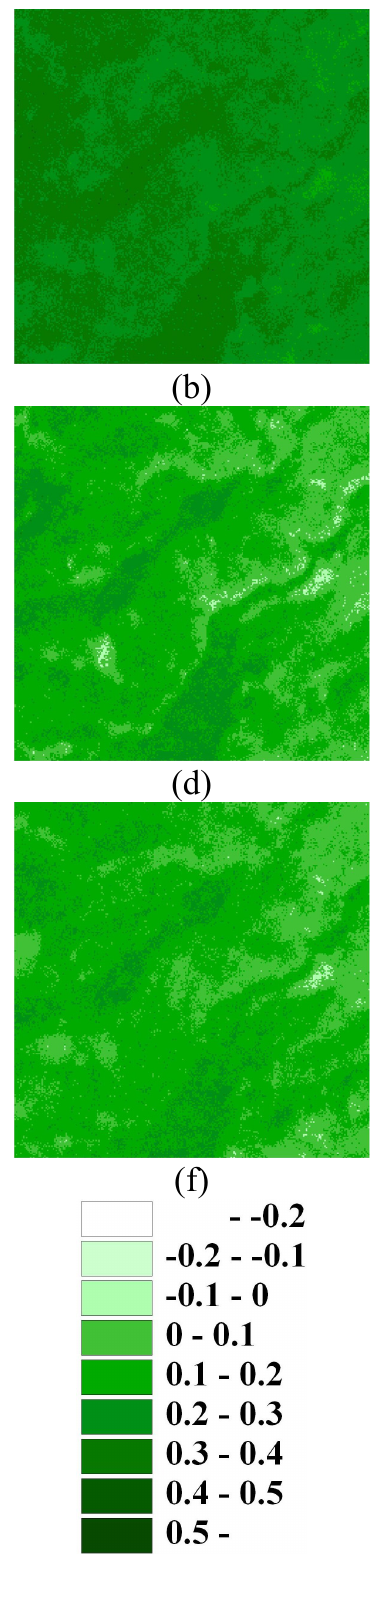
Figure 10. SGS simulated NDVI images based on 5,000 samples for area on (a) 1996/11/08, (b) 1999/03/06, (c) 1999/10/31, (d) 2000/11/27, (e) 2001/11/20, (f) 2003/12/17, and (g)